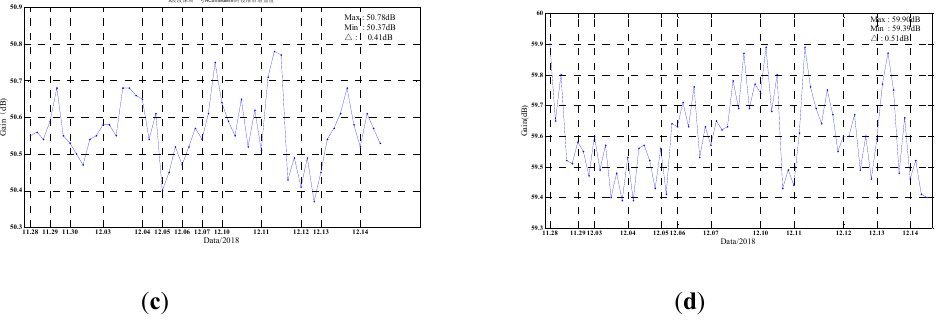
Figure 11. Gain during the two week period: ( a ) L-band; ( b ) C-band; ( c ) X-band; ( d ) Ka-band.